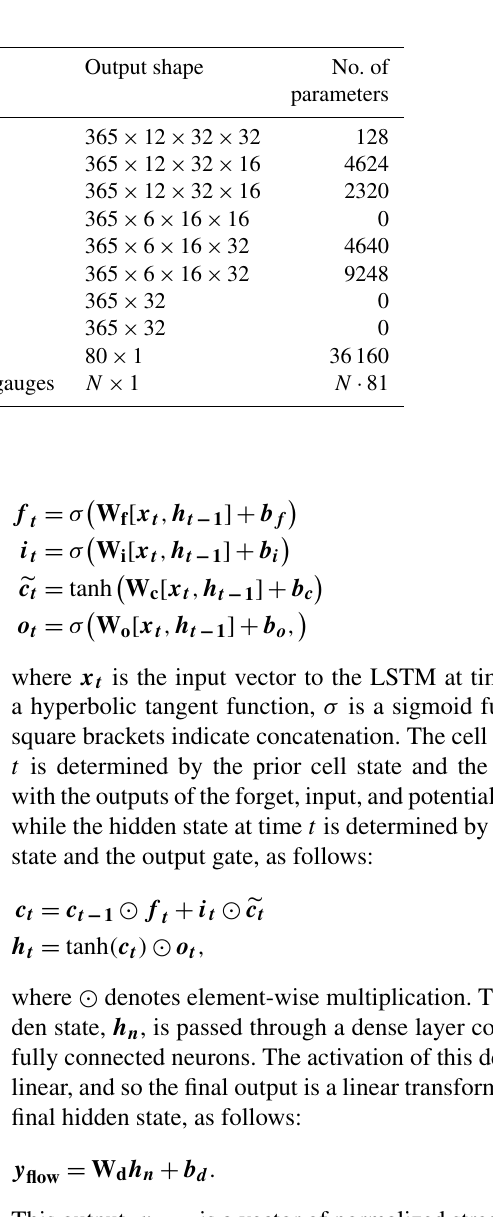
Table 1. Details of the model layers. The model input has a shape of 365 × 12 × 32 × 3, with the final dimension corresponding to the three input variables (daily maximum temperature, minimum temperature, and precipitation). Note that each of the 365 daily weather images is passed independently through the convolutional and pooling layers (e.g. these layers are time distributed), and so the output shape of these layers has a first dimension of